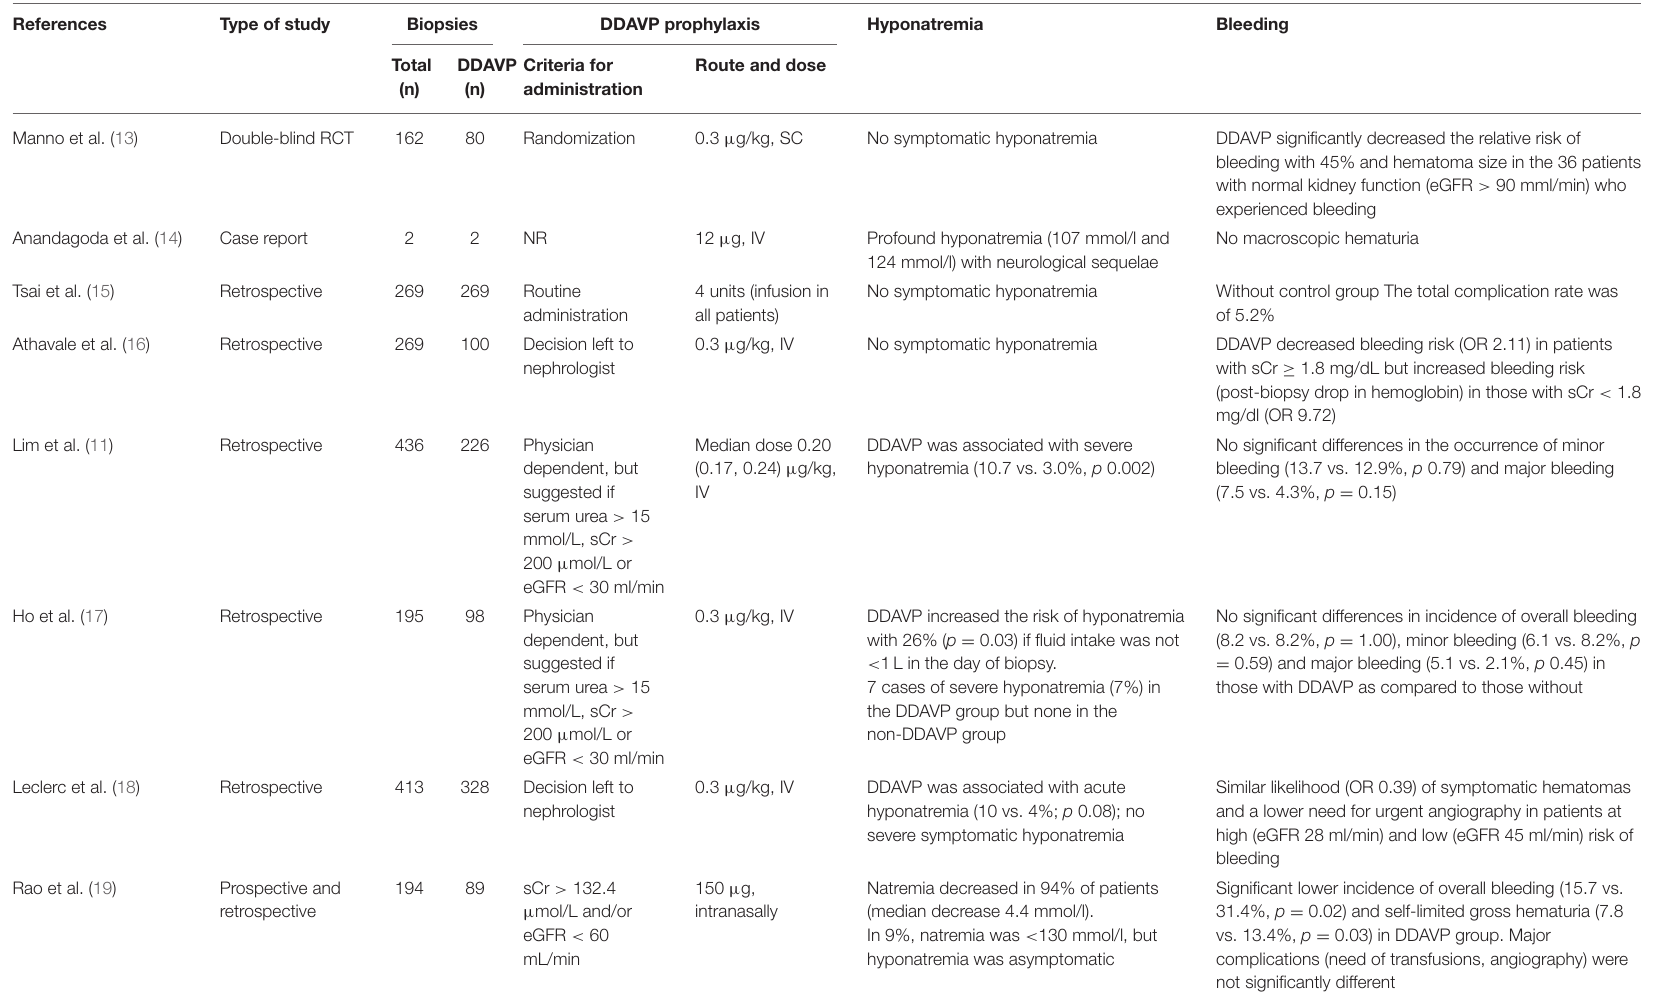
TABLE 2 | Studies reporting hyponatremia and bleeding after prophylactic desmopressin (DDAVP) administration prior to kidney